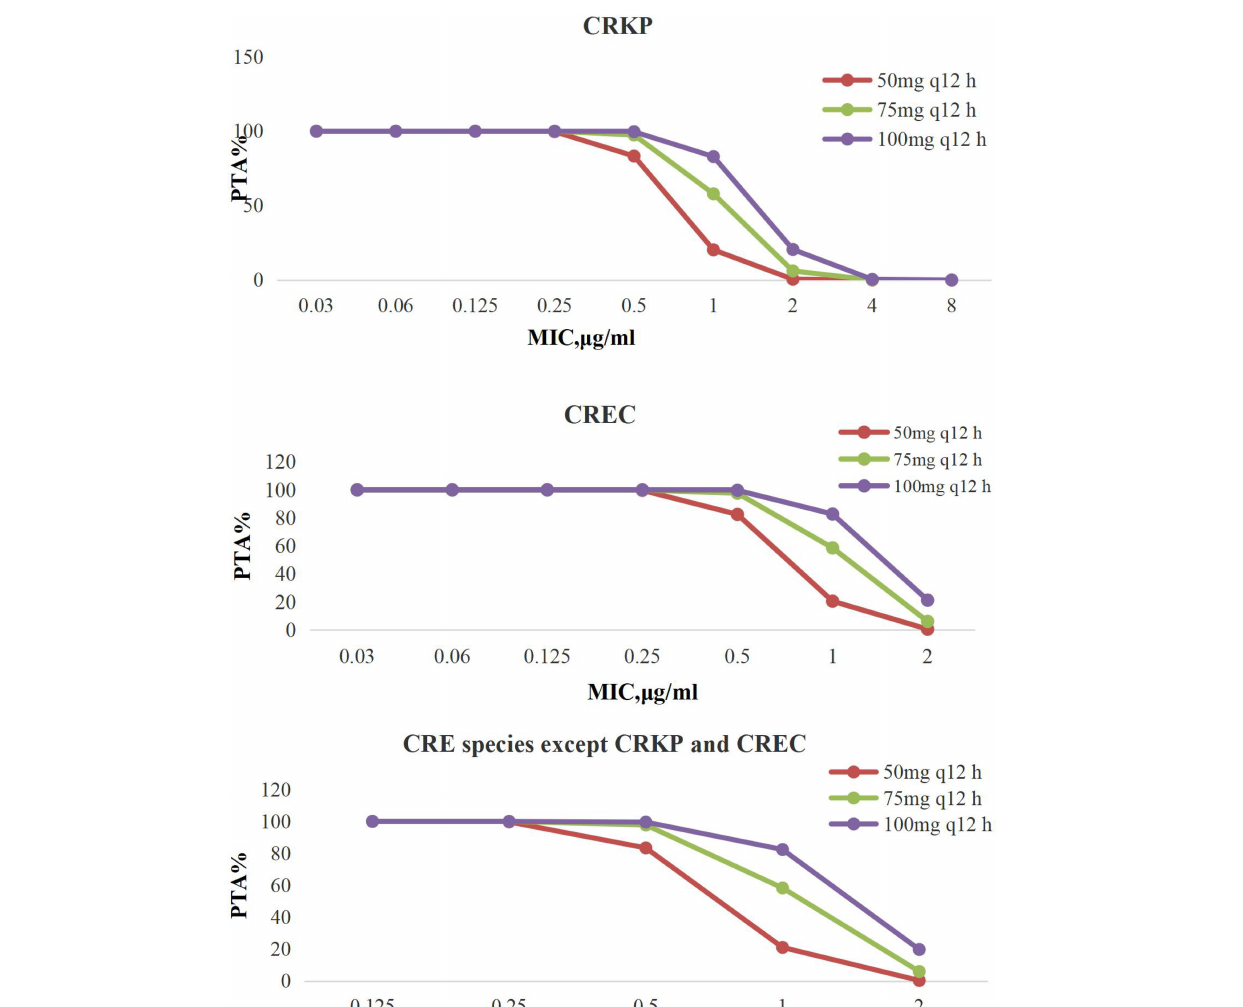
Frontiers in Microbiology |